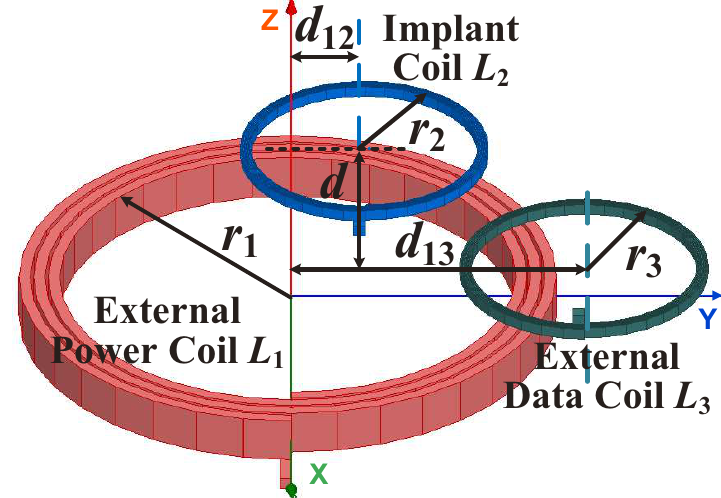
Figure 3. 3D model of the magnetic-balanced inductive